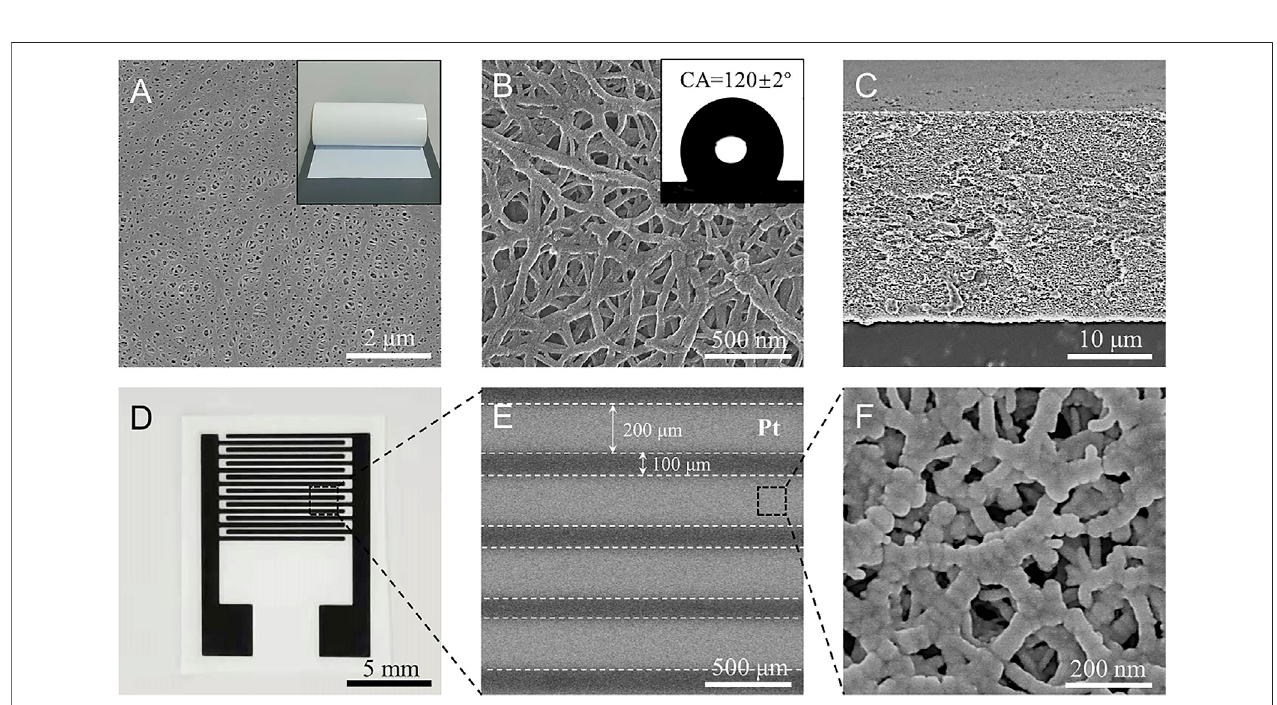
FIGURE2 |(A,B) Scanning electron microscopy(SEM) images ofthe porous polyethylenemembrane substrate at lowand high magni fi cation, respectively.Insets in (A,B) show photographs of the membrane and water droplets on it with a contact angle of about 120 ± 2 ° . (C) Cross-section SEM image of the membrane with a thicknessofabout25 μ m. (D) PhotographofPt-Ptelectrodessputtered ontheporoussubstratewitheightpairsofelectrodes. (E,F) areSEMimagesofthePtelectrode atlowandhighermagni fi cations.Theelectrodeband-widthis200 μ m,thegapbetweentheinterdigitatedelectrodesis100 μ m.ThePtelectrodealsohasaporous